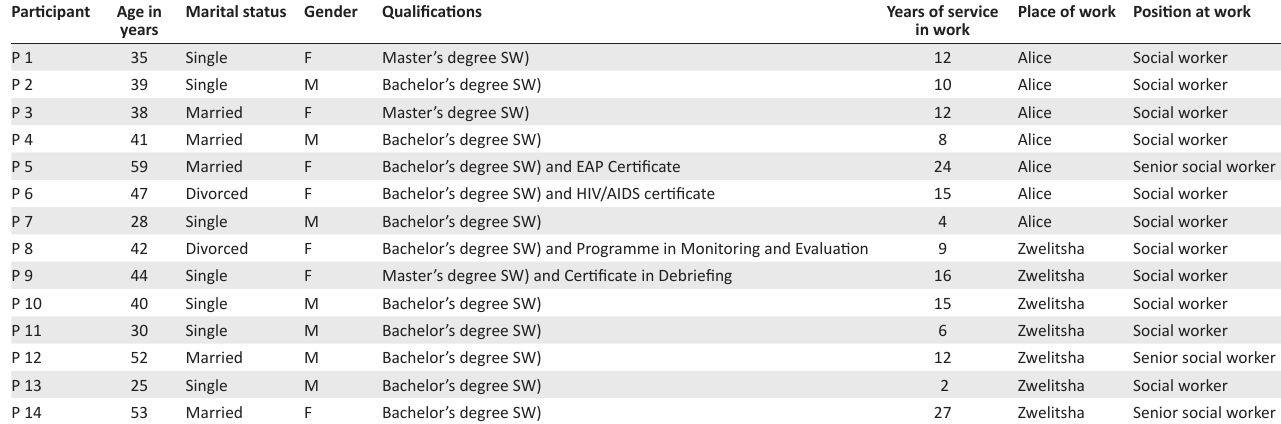
TABLE 1: Biographical information of the participants.